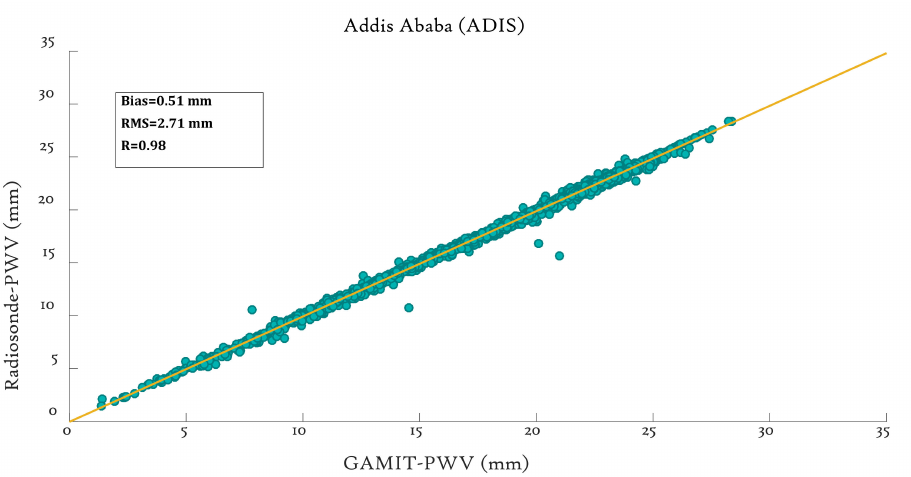
Figure 2. Scatter plot of radiosonde-PWV versus GAMIT-PWV for Addis-Ababa (ADIS) during